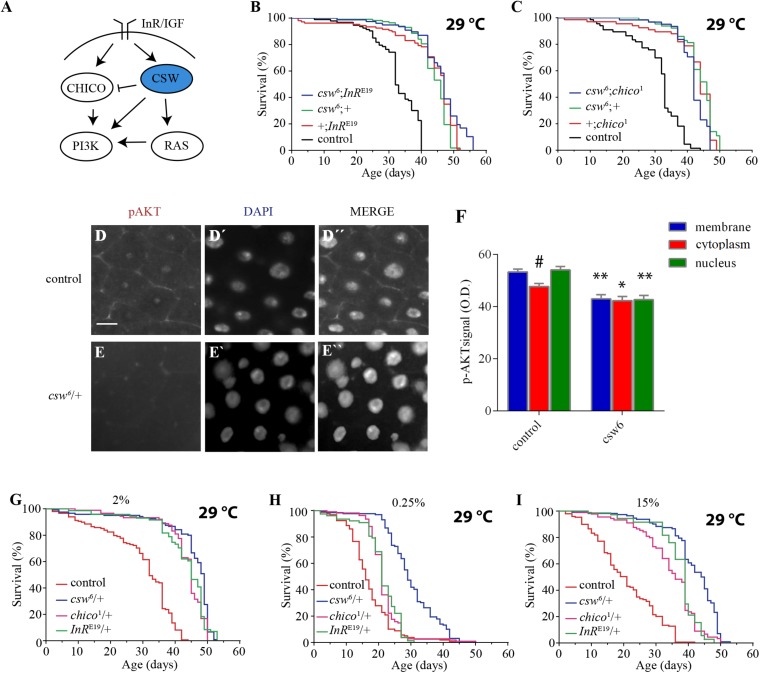
Loss-of-function (LOF) csw interacts with the insulin pathway reducing AKT activation and extended life span in poor and rich diets. (A) Simplified schematic representation of the roles of the vertebrate tyrosine phosphatase SHP2 and ortholog of CSW in fruit flies. Arrows indicate positive regulatory effects, and blunt arrow indicates negative regulatory effect. Note the predominant positive effect of SHP2. (B,C) Non-additive effect on life span curves by genetic interaction of LOF csw6 with classical insulin mutants, InRE19 and chico1. (B) Double mutant csw6; InRE19 compared with single mutants (csw6;+ and +;InRE19) and +;+ (control). (C) Double mutant csw6; chico1 compared with single mutants (csw6;+ and +;chico1) and +;+ (control). (D–F) Immunostaining showing reduced AKT activation in LOF csw posterior midguts, using anti-pAKT. Representative staining in control (D) and LOF csw6 gut (E) showing pAKT, DNA staining (D’,E’), and merged staining (D”,E”). Scale bar 10 μm. (F) Average optical density of pAKT, corresponding to plasma membrane, cytoplasm, and nucleus for mutant (csw6/+) and control (+/+) fruit flies. Each bar represents 40 data points from four different animals. Asterisks indicate significant reduction in csw6/+ compared with control guts, ∗∗p < 0.0001; ∗p < 0.05; and # indicates significant reduction in cytoplasm compared with plasma membrane or nucleus in control group, two-way ANOVA, Sidak’s multiple comparison test. (G–I) Survival curves showing extended life span in poor and rich yeast diets of csw6/+ and classical insulin mutants, InRE19/+ and chico1/+, compared with control group +/+ cultured in fly media containing the concentrations of yeast: 2% (G), 0.25% (H), and 15% (I). The three mutants showed extended life span as compared with control group, p < 0.0001, log-rank test, corrected for multiple comparisons. For the panels (B,C,G–I), the number of animals was n = 61 to 129, at least from three independent experiments.